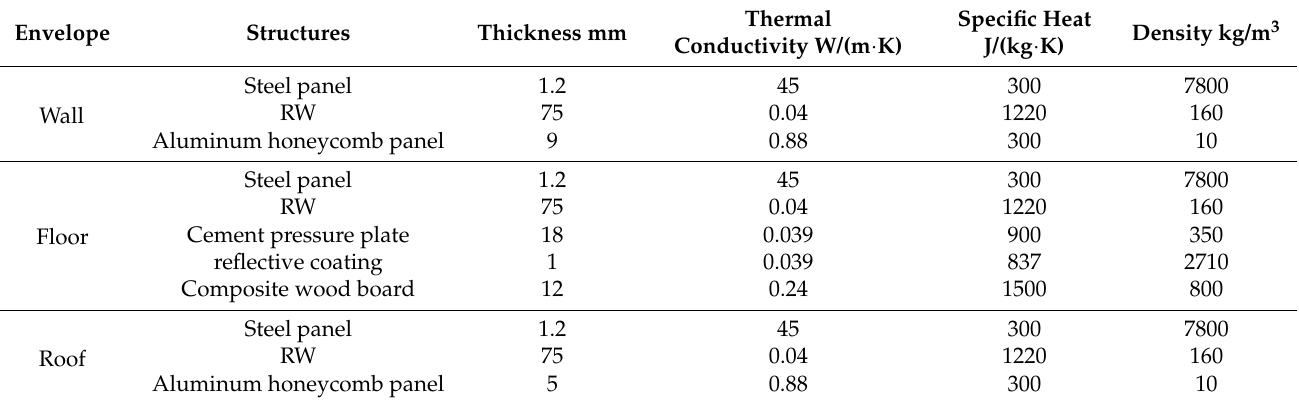
Figure 3. ( a ) The photo of the experimental CH; ( b ) The dimensions of the CH; ( c ) Simulation model. Table 1. Thermophysical parameters of non-transparent envelope.